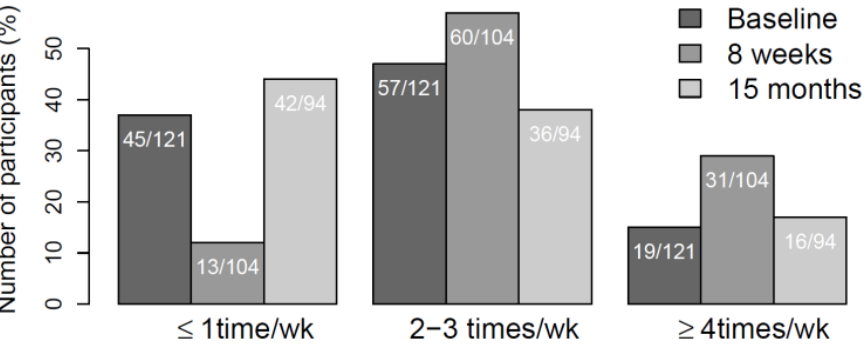
Figure 2. Change in weekly physical activity level; baseline, the 8-week and 15-month follow-up. Diastolic and systolic blood pressure ( dBP / sBP ). The significant increase in dBP registered at the 8-week follow-up [20] did not persist in the period from 8 weeks to 15 months. For the period from baseline to 15 months of follow-up, there was, however, a significant increase in dBP and sBP for men. See Table 2, Figure 3.